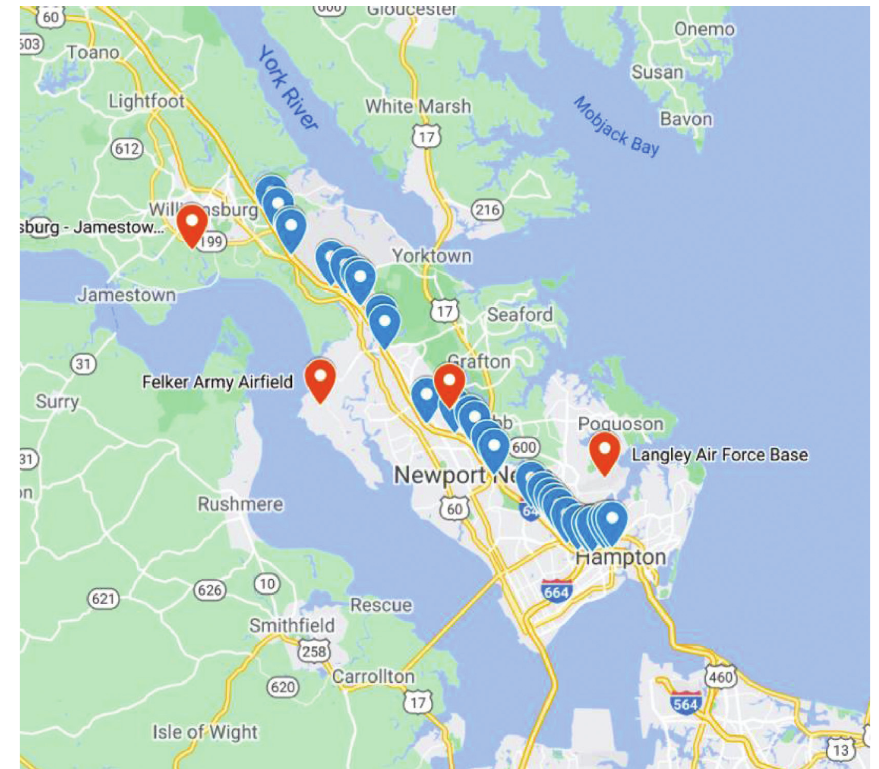
Figure 2: Layout of the study area on I-64, VA, where the blue markers show the start location of the TMCs and the orange markers show the location of the weather stations (source: Google